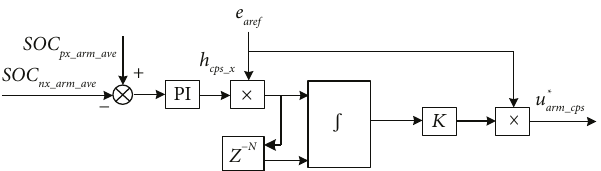
Figure 14: Equalization correction control of upper and lower bridge arms.